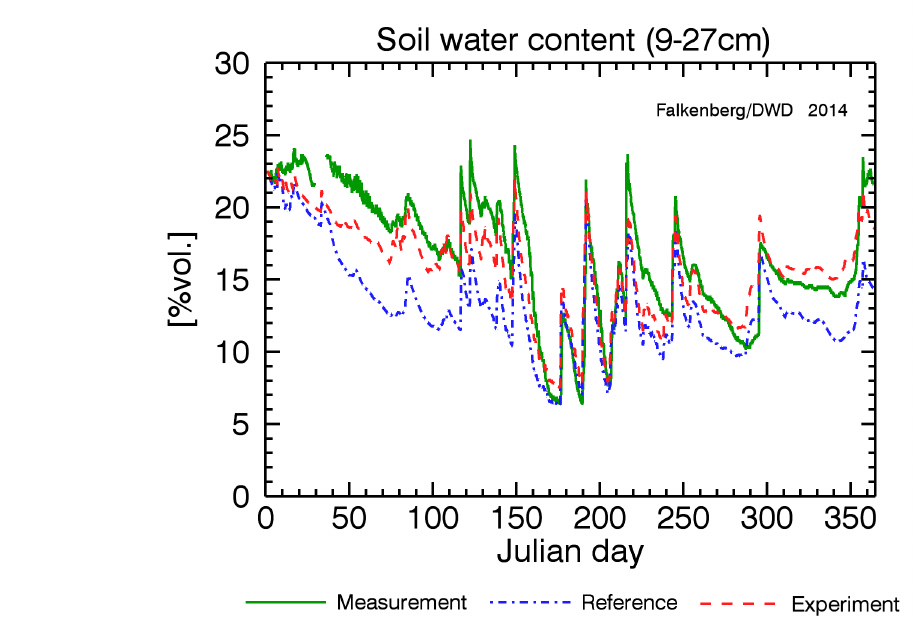
Figure 5. Annual cycle of the soil water content at a depth of 9–27 cm as measured at Falkenberg during 2014 compared to the results of the reference version of TERRA based on BATS and of the new scheme based on a resistance formulation